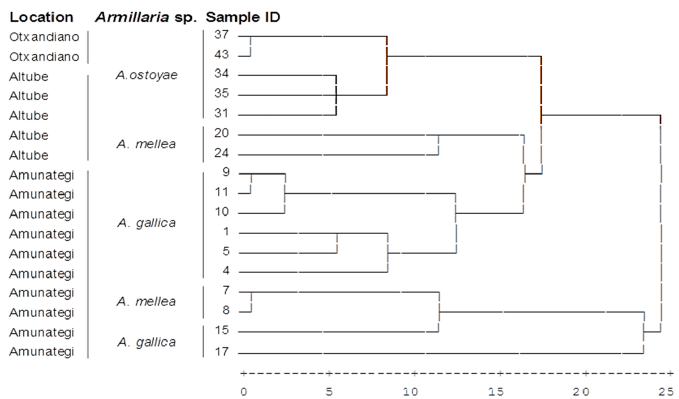
Figure 8. Genetic relationships among Armillaria strains. The dendrogram was generated by the average-linkage method of clustering using the distances calculated by simple matching coefficient among the binomial matrix obtained from UP-PCR banding patterms using AS4 universal primers.